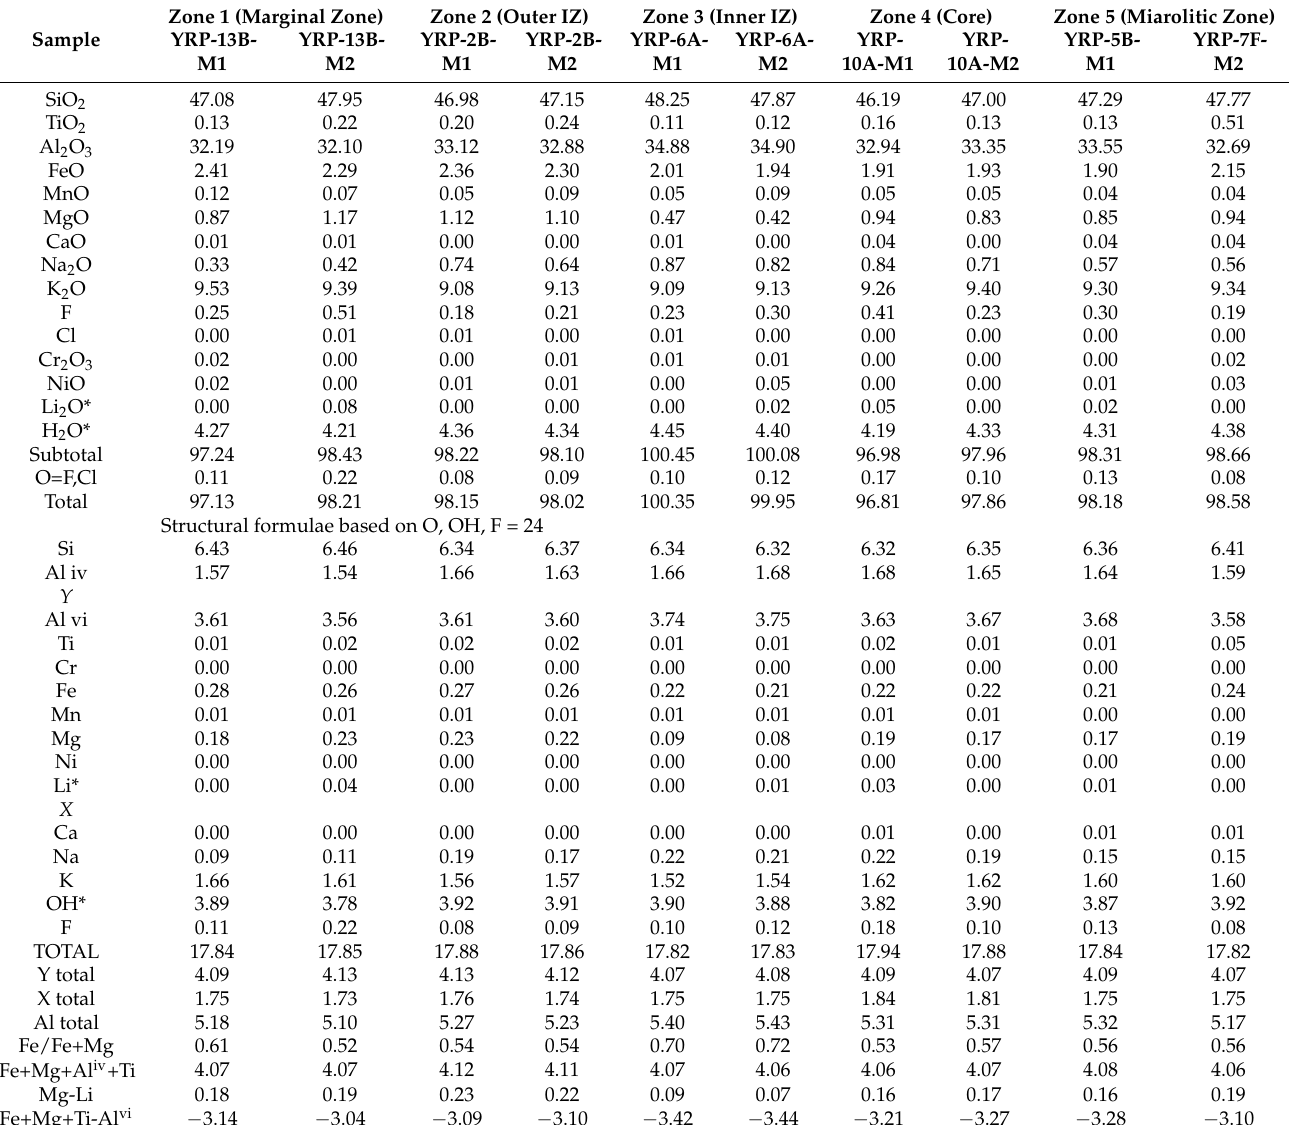
Table 5. The representative EPMA major element composition of muscovite from the Yamrang Pegmatite, Ikhabu Pegmatite Field (IPF), Eastern